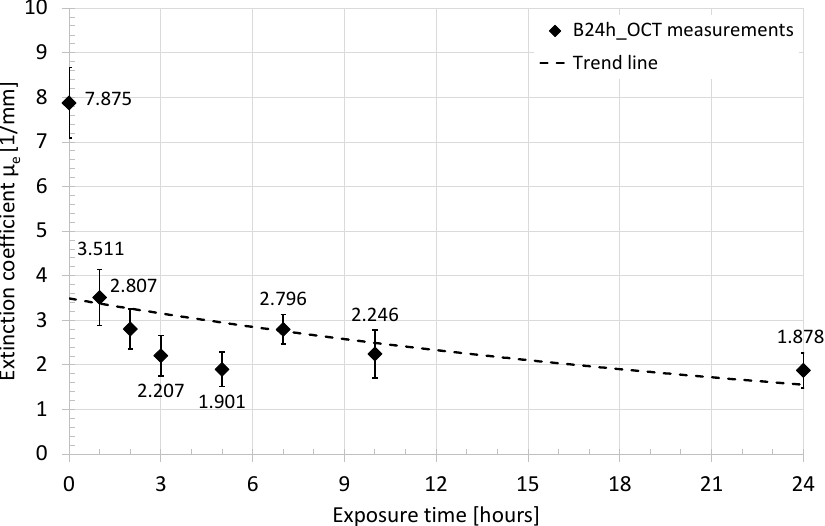
Figure 6. The average value of the extinction coefficient measured in the first 24 h of the experiment—sample B24h_OCT.